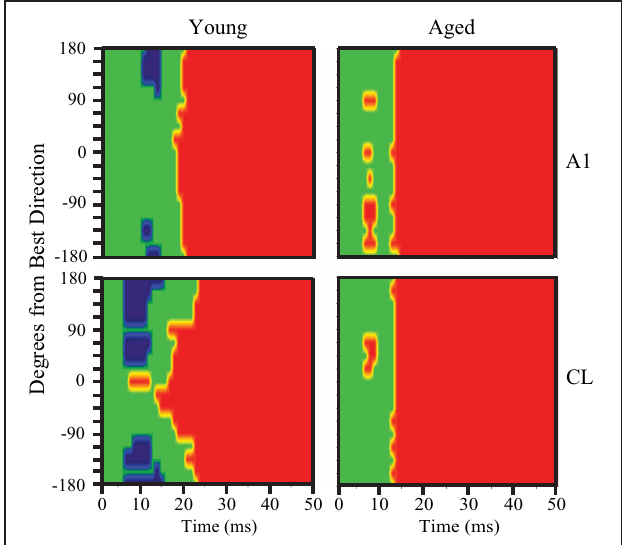
FIGURE 9 | Pre-onset inhibition in young but not aged monkeys. Each panel shows the bins that have significantly less (blue) or significantly more (red) activity compared to spontaneous. The population response of young animals is shown at the left, aged animals to the right, with A1 neurons in the top row and CL neurons in the bottom row. A1 of young animals shows pre-onset inhibition at the directions farthest from the best direction, but in CL this is true across a broader spatial extent (bottom left). In contrast, aged animals show no pre-onset inhibition at any